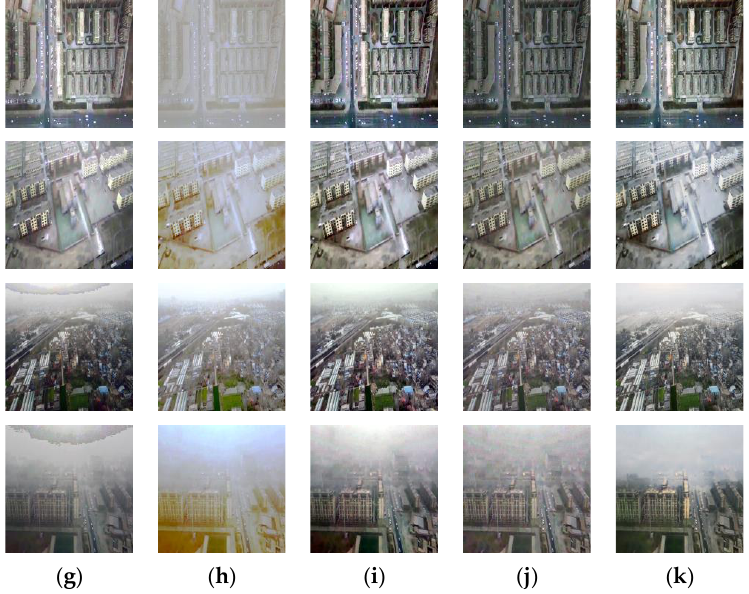
Figure 7. Qualitative comparison results on test set ASI; ( a ) Aerial sand-dust images; ( b ) TF; ( c ) GDCP; ( d ) RDCP; ( e ) CC; ( f ) FSS; ( g ) VR; ( h ) RBCP; ( i ) SES; ( j ) AOP; ( k ) Proposed.